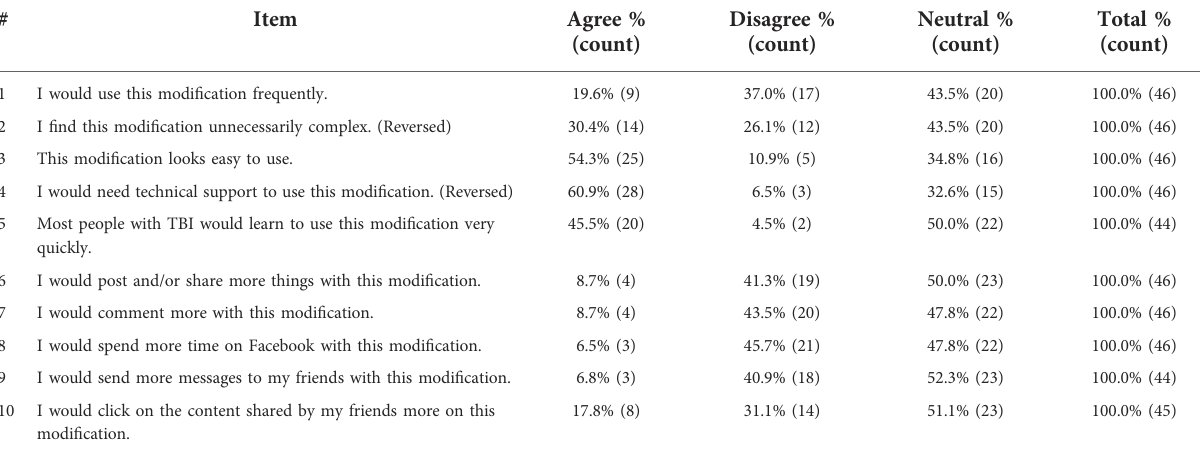
TABLE 3 Summary of participants ’ responses for attention